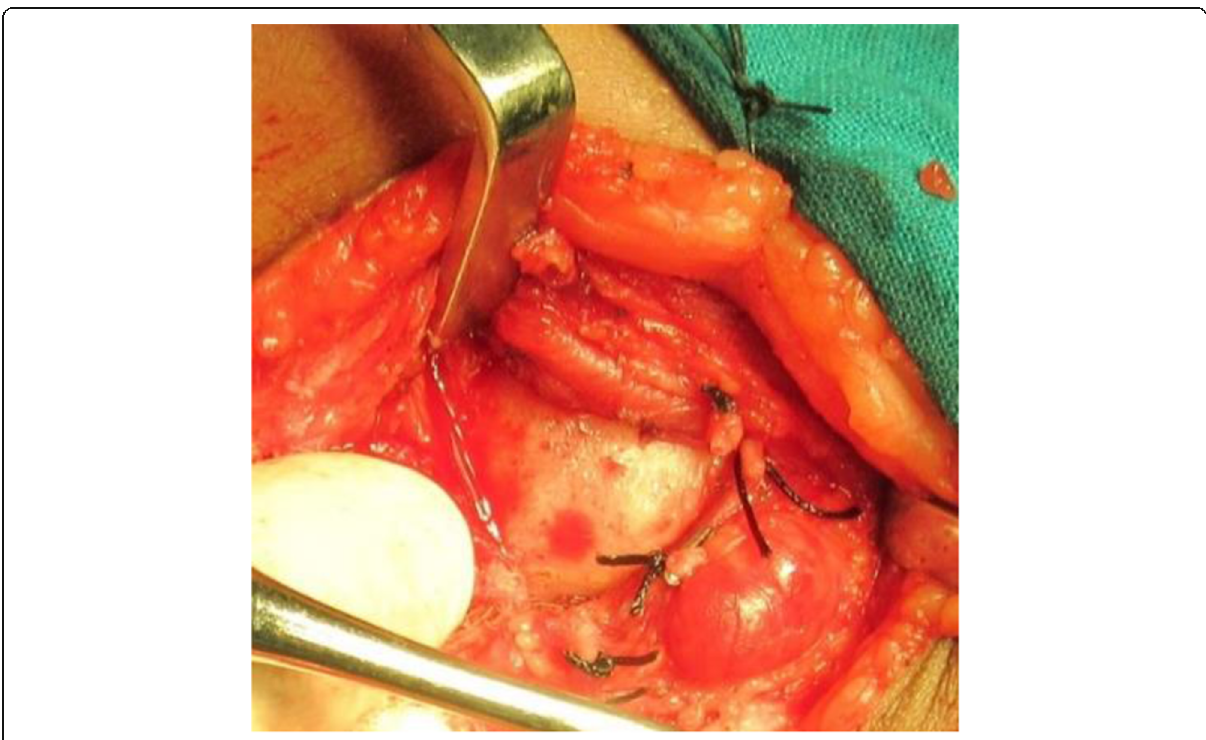
Fig. 17 Pterygo-masseteric sling